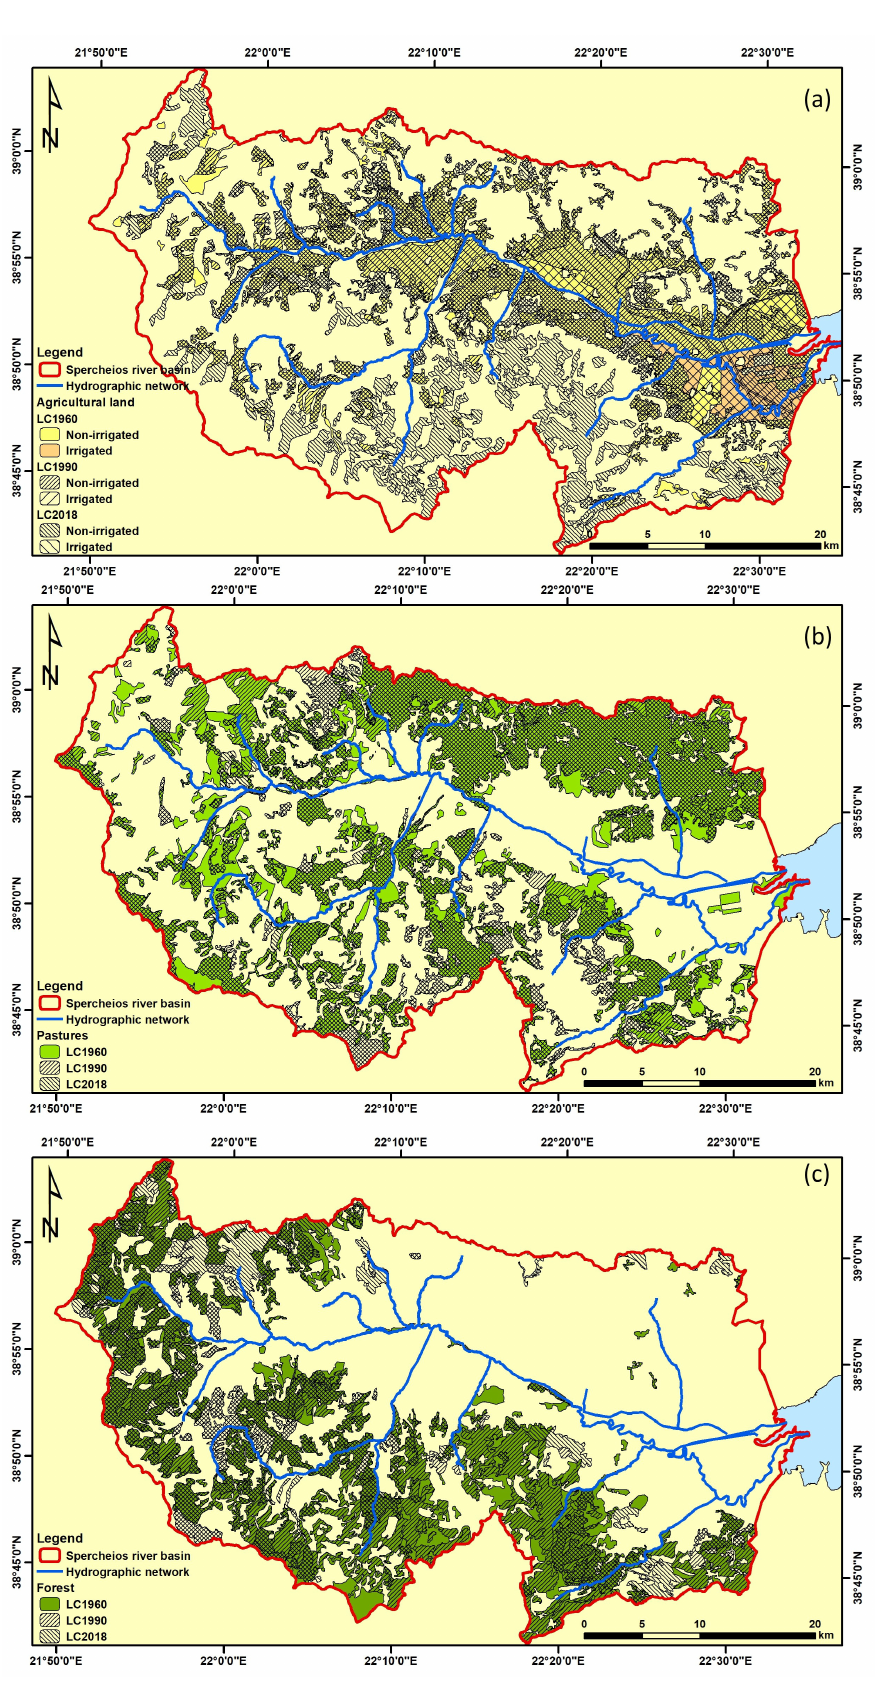
Figure 5. Di ff erences in agricultural land ( a ), pastures ( b ) and forests ( c ) for the three land cover case studies